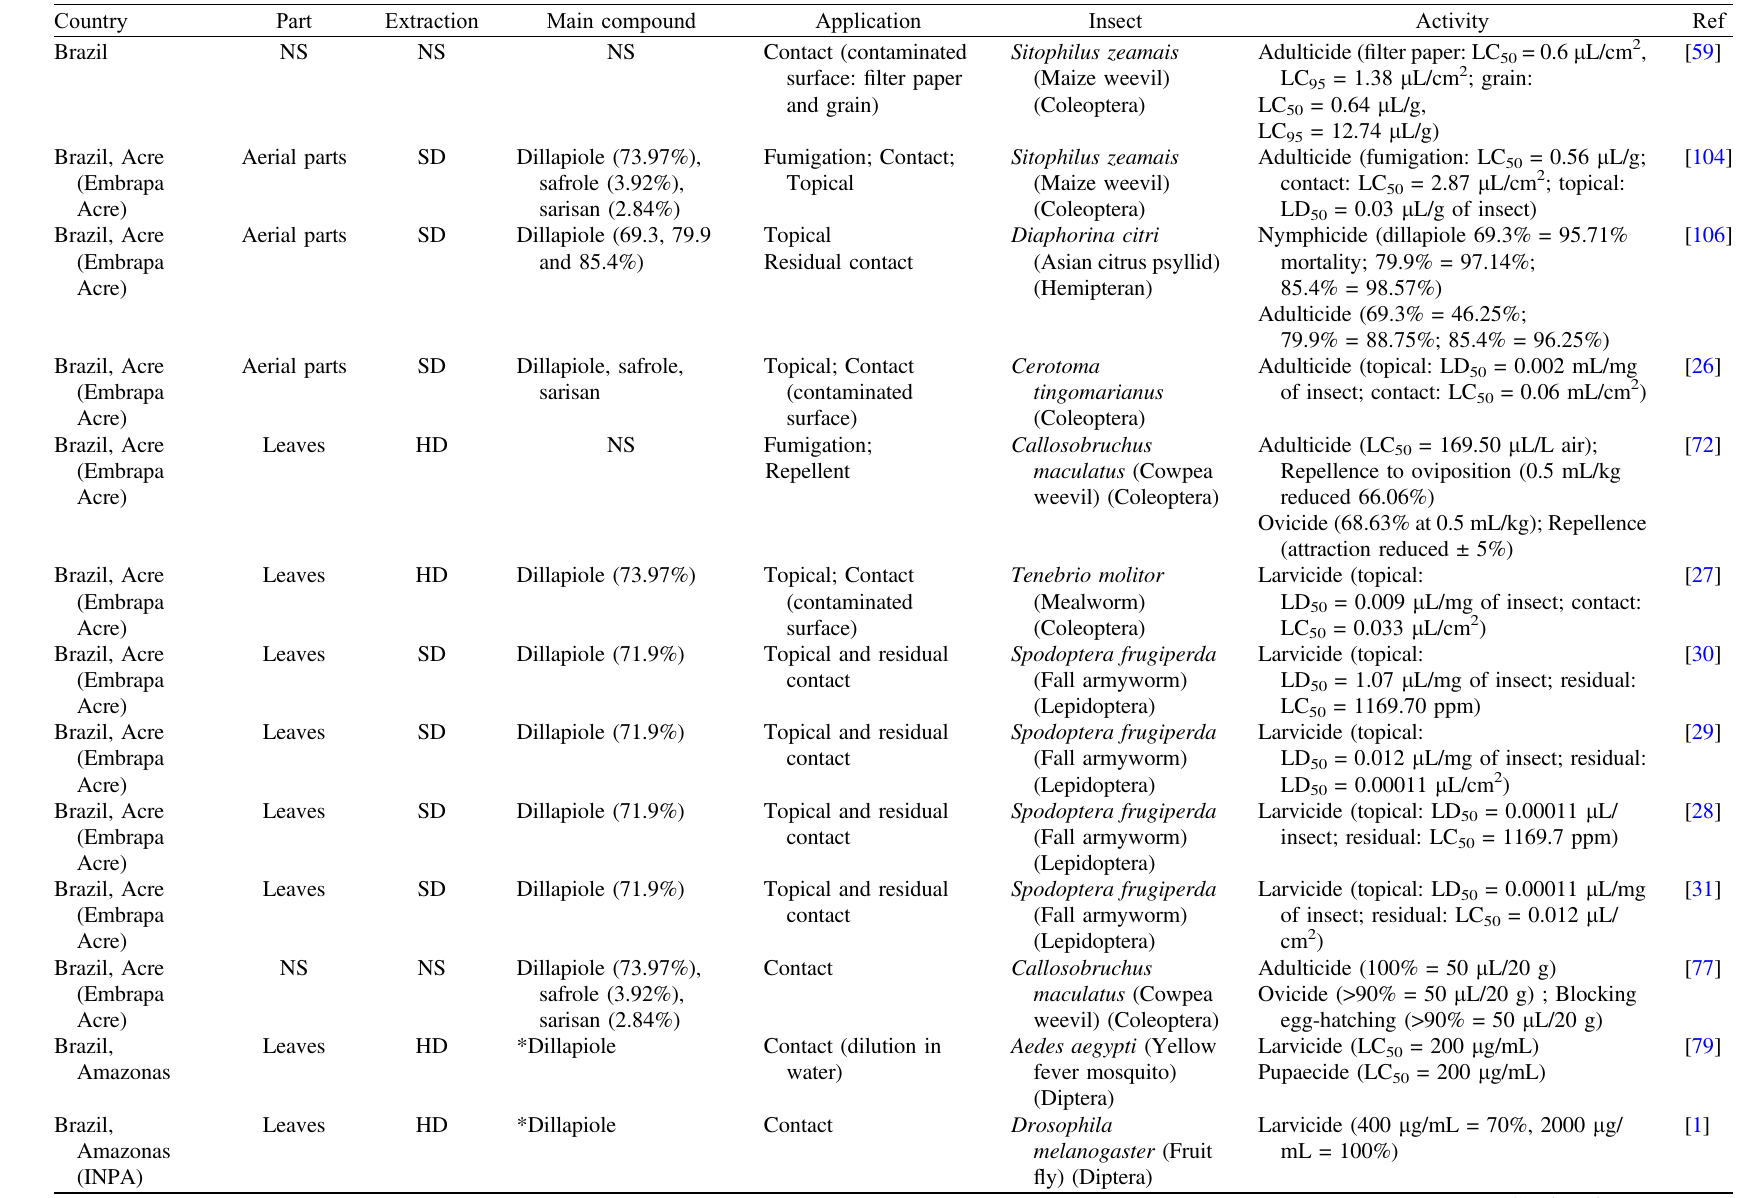
Table 2. Insecticidal